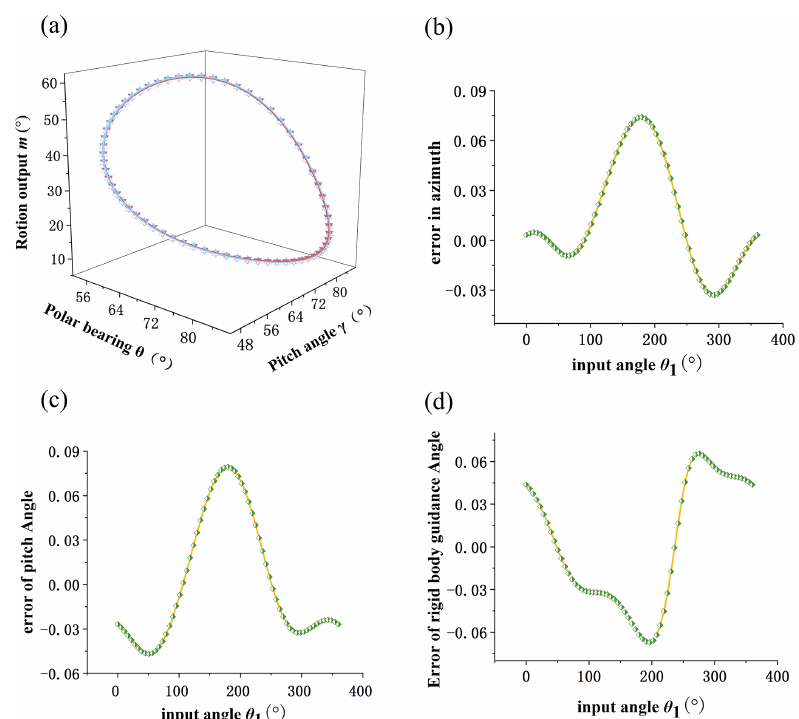
Figure 11. Comparison drawing of the first group of dimensions.